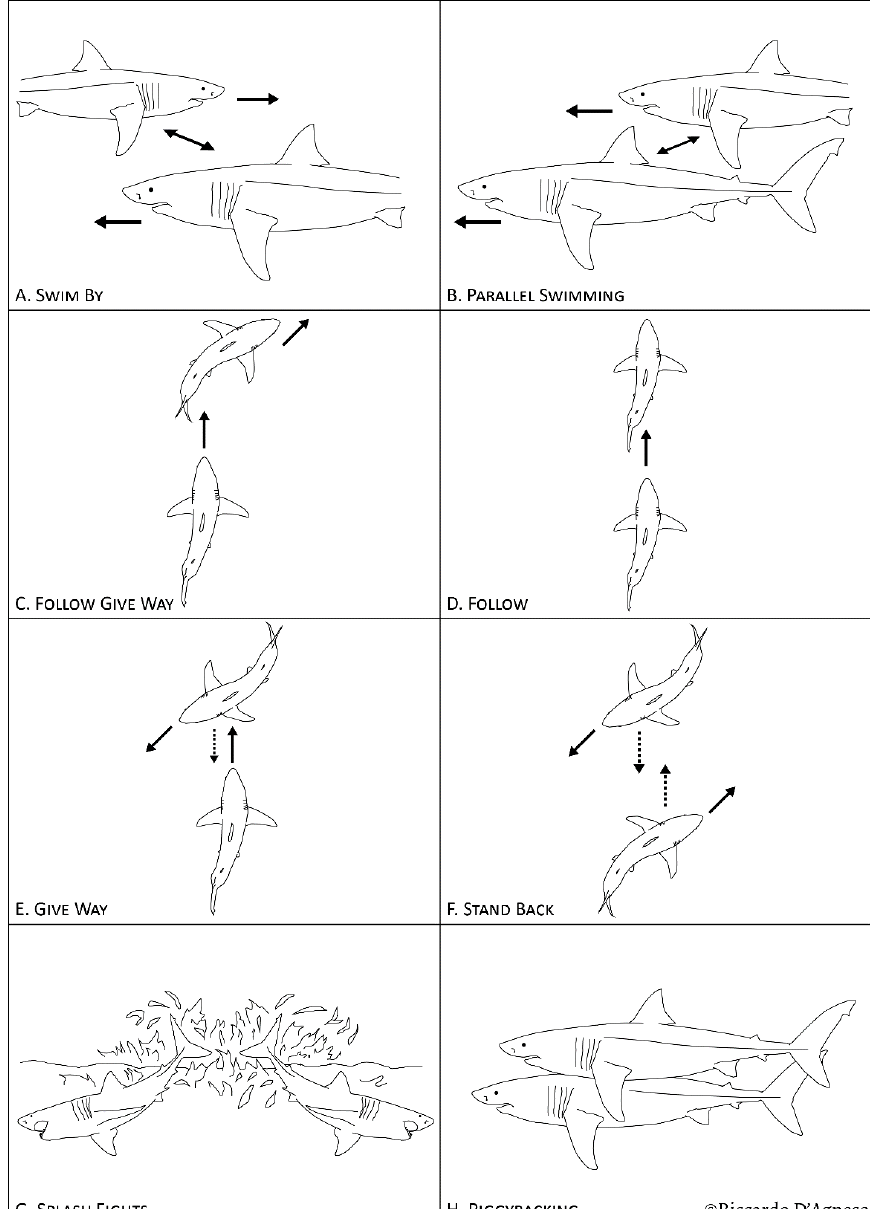
Figure 4. Eight social behaviors observed among white sharks ( Carcharodon carcharias ): swim by ( A ); parallel swim ( B ); follow/give way ( C ); follow ( D ); give way ( E ); stand back ( F ); splash fight ( G ); piggyback ( H ).